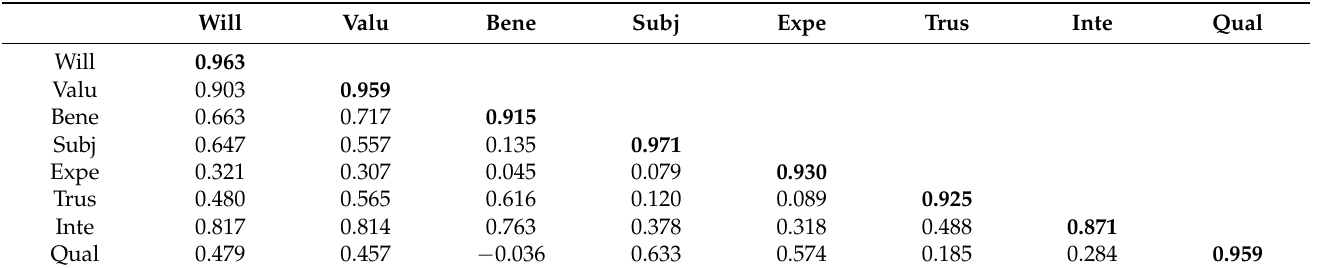
Table 4. Correlations among constructs and the square root of the AVE.